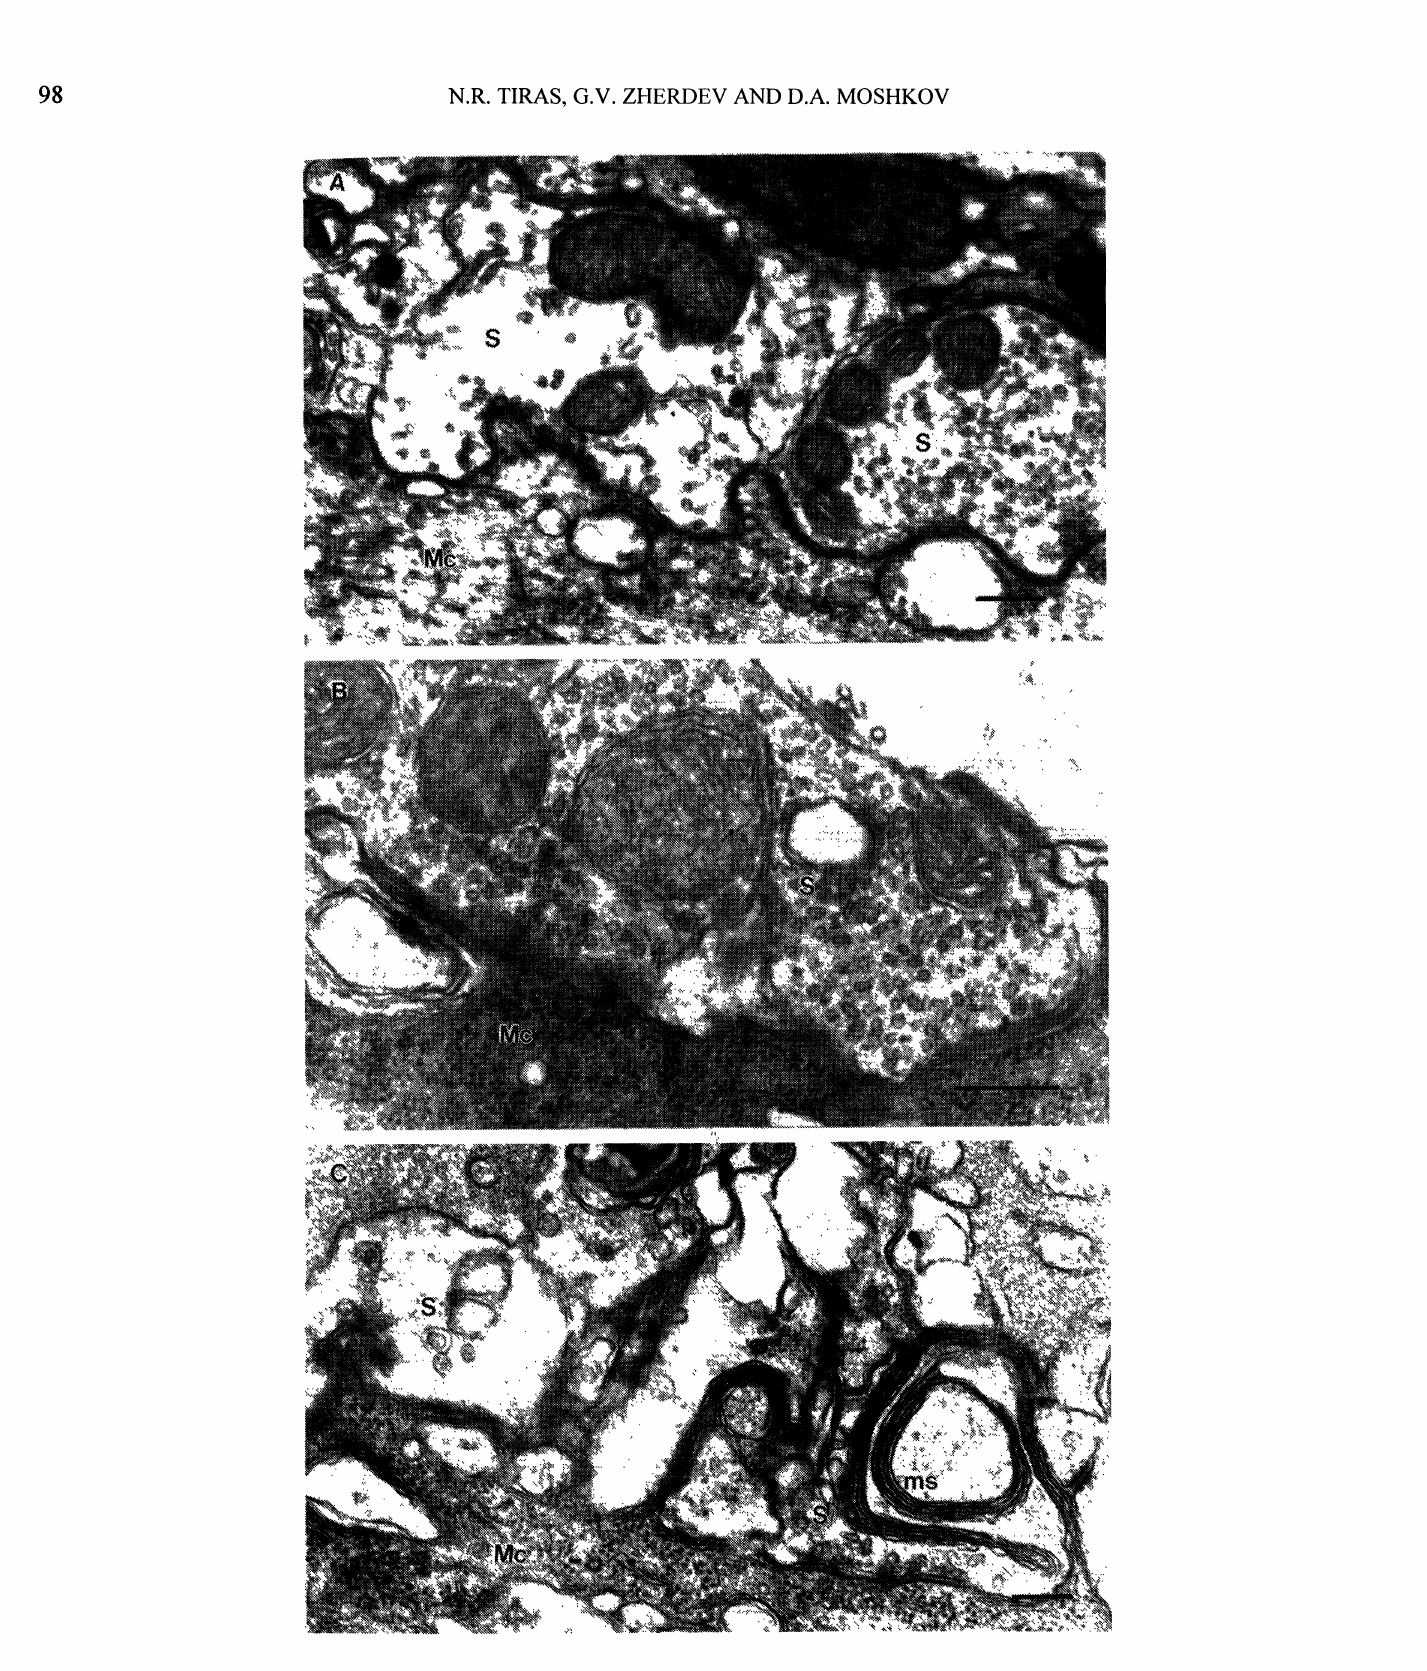
Fig. 3: Synaptic boutons on M-cell soma aider LDS of (a) untrained fish, (b) trained fish, and (c) untrained fish exposed to ethanol. (a) Note a decreased number of synaptic vesicles, ruffled contours of synaptic membranes. (b) Training followed by LDS causes no changes in the number of synaptic vesicles. (c) The same structural features as in (a) and in Fig. 2b,c are observed: empty boutons, horseshoe-shaped myelin-like structures without synaptic vesicles inside them. Abbreviation as in Fig. and 2. Scale bar for Fig. a and b 0.25 tm, for c=0.2